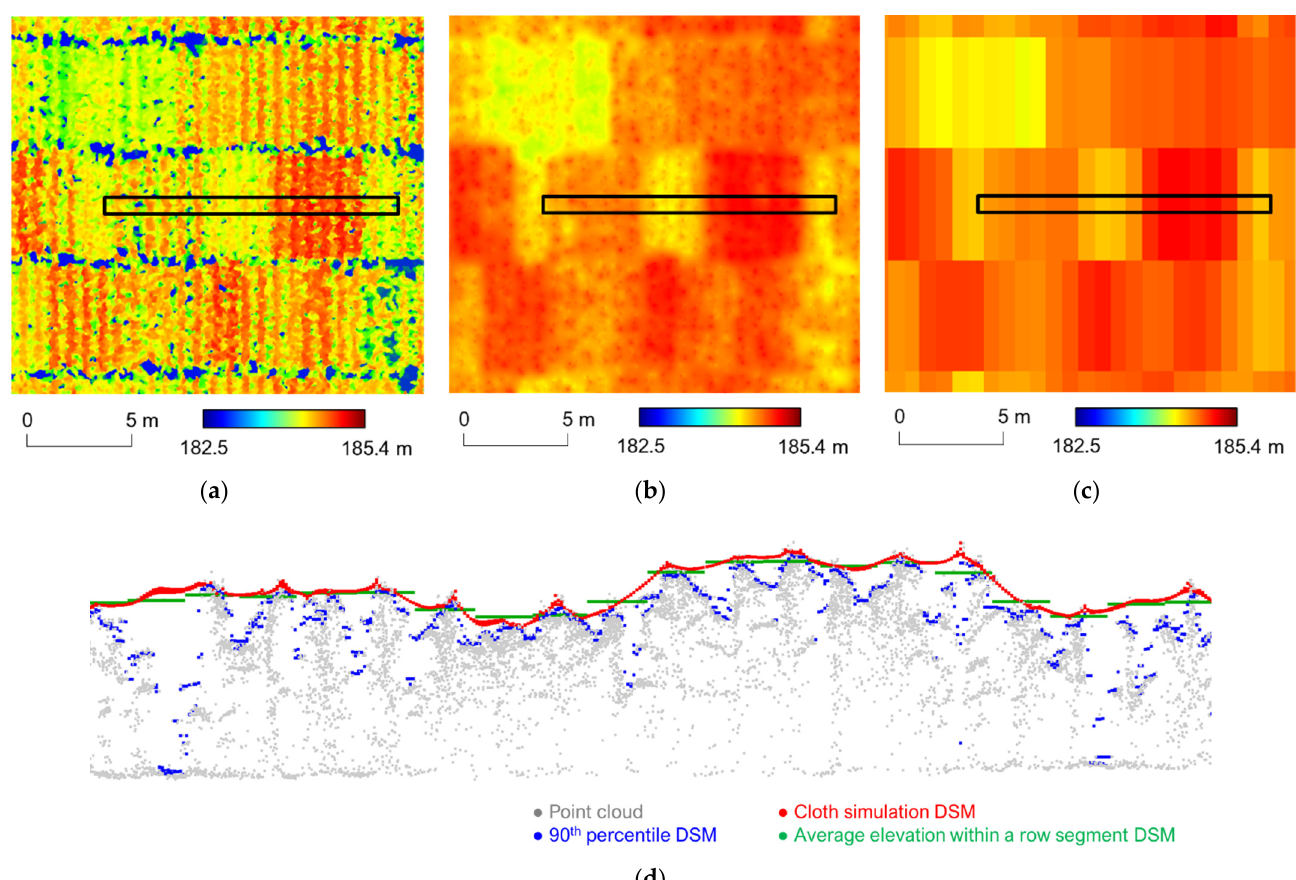
Figure 10. Sample digital surface model (DSM) generated using ( a ) 90th percentile, ( b ) cloth simulation, and ( c ) average height. A selected area for DSM comparison is shown in the black box. ( d ) Side view of the selected area showing the point cloud and generated DSMs using different approaches.